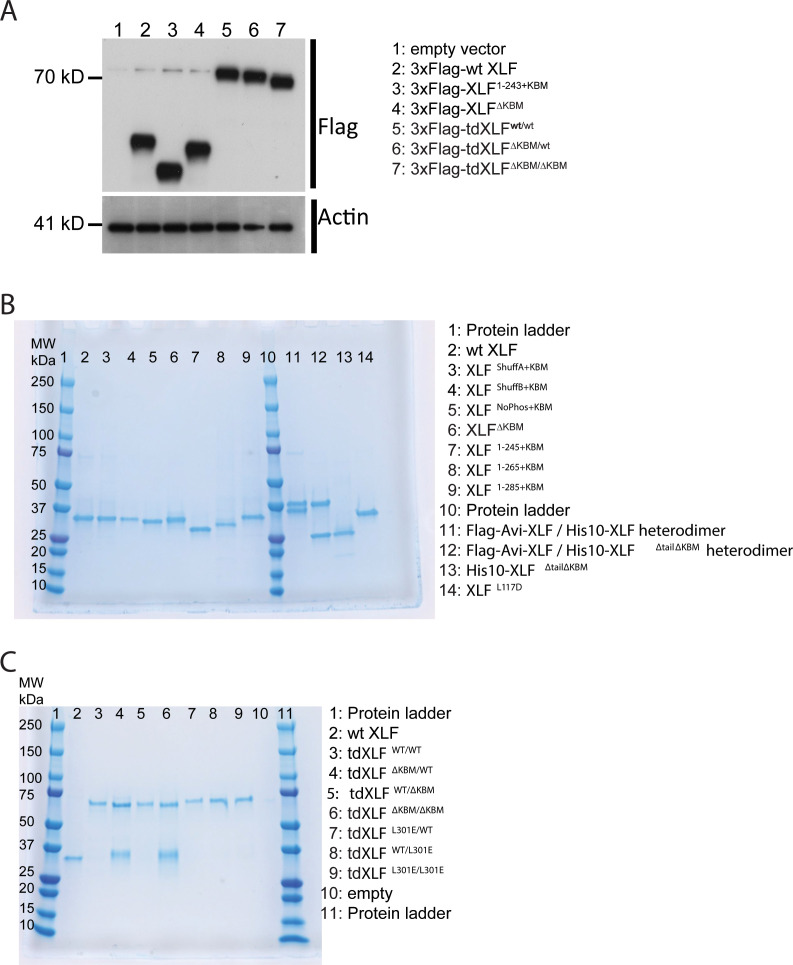
XLF constructs.(A) Expression of XLF constructs in mESCs after transfection with the indicated constructs within the pCAGGS-BSKX vector. Samples of extract from each transfection were blotted with both anti-Flag and anti-Actin antibodies. (B) XLF mutants and heterodimer constructs. For each construct, 1500 ng was loaded on a 4–15% Mini-PROTEAN TGX Precast Protein Gel (BioRad). For each heterodimer, 3 µg construct was loaded so that individual bands should be of the same intensity as the other XLF constructs. (C) Tandem dimer XLF constructs. 750 ng of wtXLF and each tandem dimer construct were loaded and run on a 4–15% Mini-PROTEAN TGX Precast Protein Gel (BioRad). tdXLF constructs where the KBM of subunit 1 was replaced with additional linker sequence (lane four tdXLFΔKBM/WT and lane six tdXLFΔKBM/ΔKBM ) purified with a contaminants that run at ~ 35 kDa on these PAGE gels. These contaminant bands were sent for mass spectrometry (Taplin Mass Spectrometry Core Facility, Harvard Medical School). Although peptides corresponding to Xenopus XLF were detected in both cases, the majority of peptides identified were from endogenous E. coli proteins, with the bacterial lipid synthesis protein, lpxD, being responsible for 72% and 41% of peptides identified from the contaminant bands within the tdXLFΔKBM/WT and tdXLFΔKBM/ΔKBM samples, respectively.